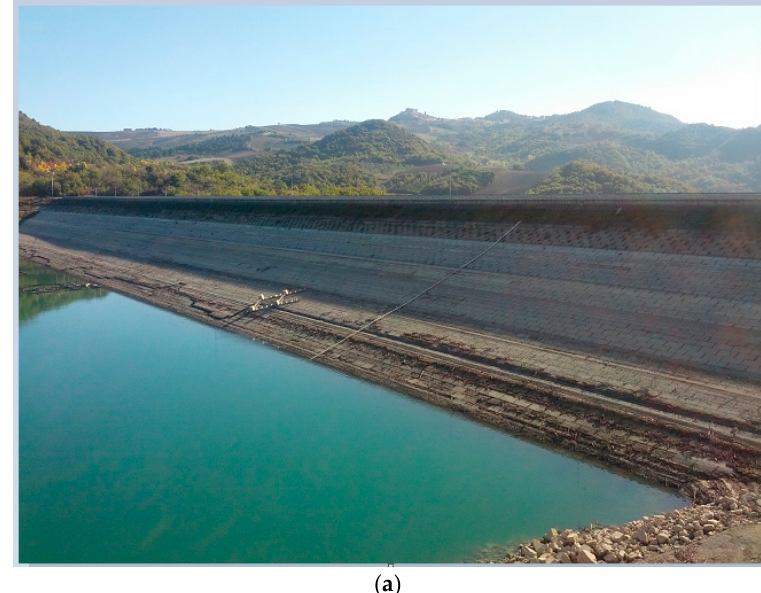
Figure 11. Occhito dam, Carlantino. ( a , b ) photo of the dam as observed from the GBSAR positions ; ( c , d ) interferometric coherence ( c , d ); ( e , f ) displacement maps in Cartesian coordinates. Data have been collected by two GBSAR systems installed on the left (SX) and right (DX) downstream sides of the dam,